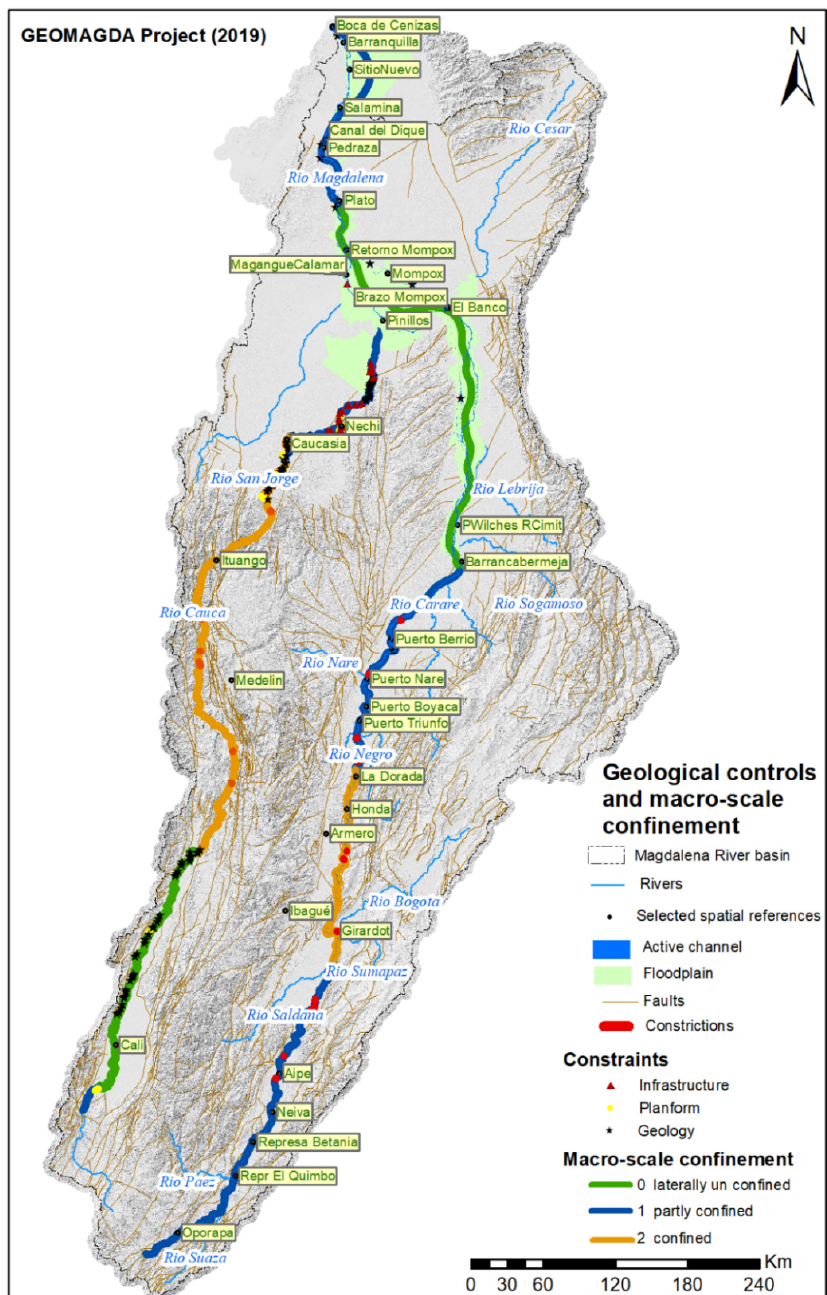
Figure 6. Tectonic and valley shape controls (confinement and constrictions) at the macro scale for the Magdalena and Cauca Rivers. The floodplain (Valley Bottom) also exists in several reaches but is not visible at this scale. Constraints to the lateral movement of rivers are shown only for the plain parts of the basin, where their blocking role is more peculiar.